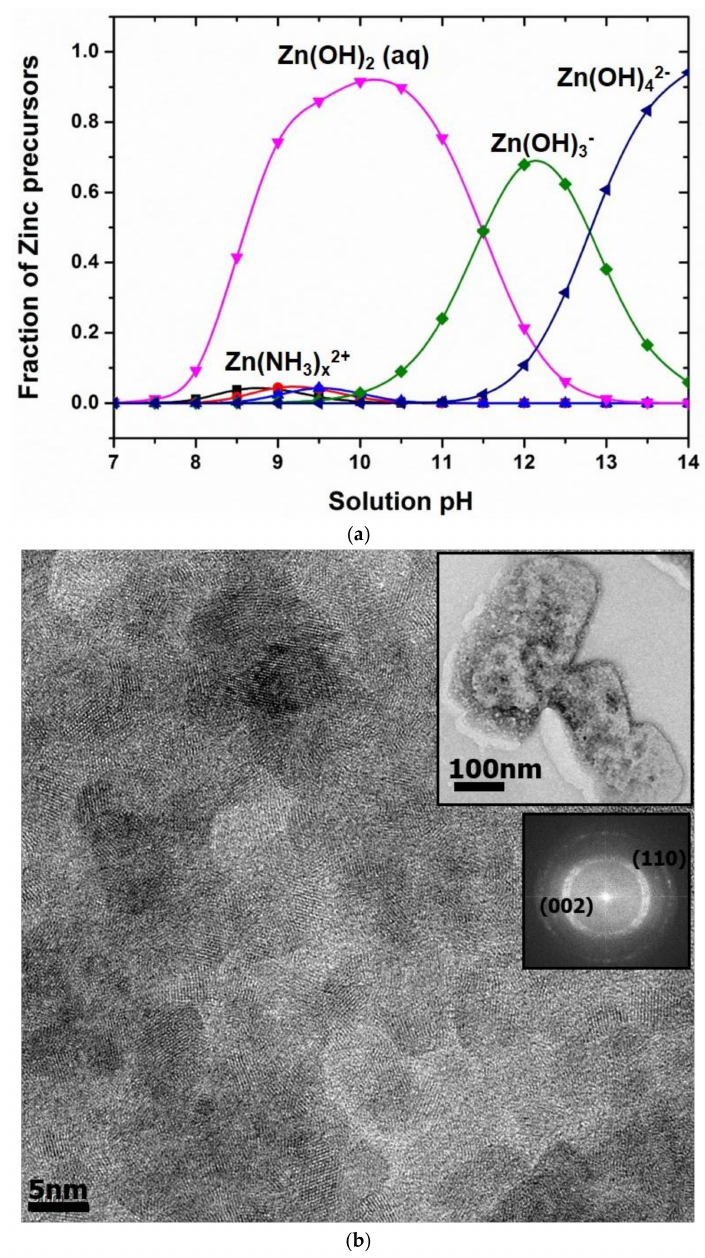
Figure 3. ( a ) speciation diagram of Zinc precursors; ( b ) TEM image of ZnO nanocrystals assembled to form rectangular structure in the MAND system (inset: TEM image of rectangular ZnO assembly and FFT image of assembled ZnO